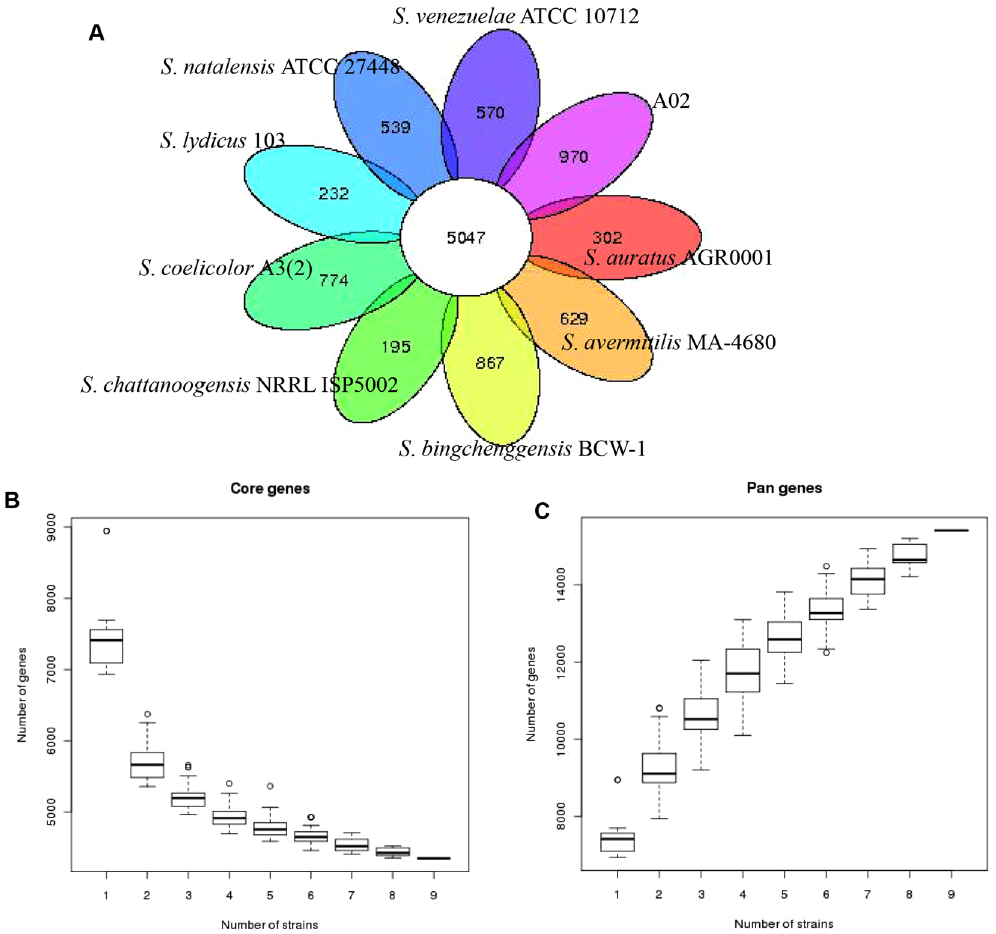
Figure 2. The pan-genome of streptomycetes. ( A ) Flower plots showing the core gene number and strain- specific gene number in 9 streptomycete strains. ( B ) Dilution curve of 9 streptomycete pan and core